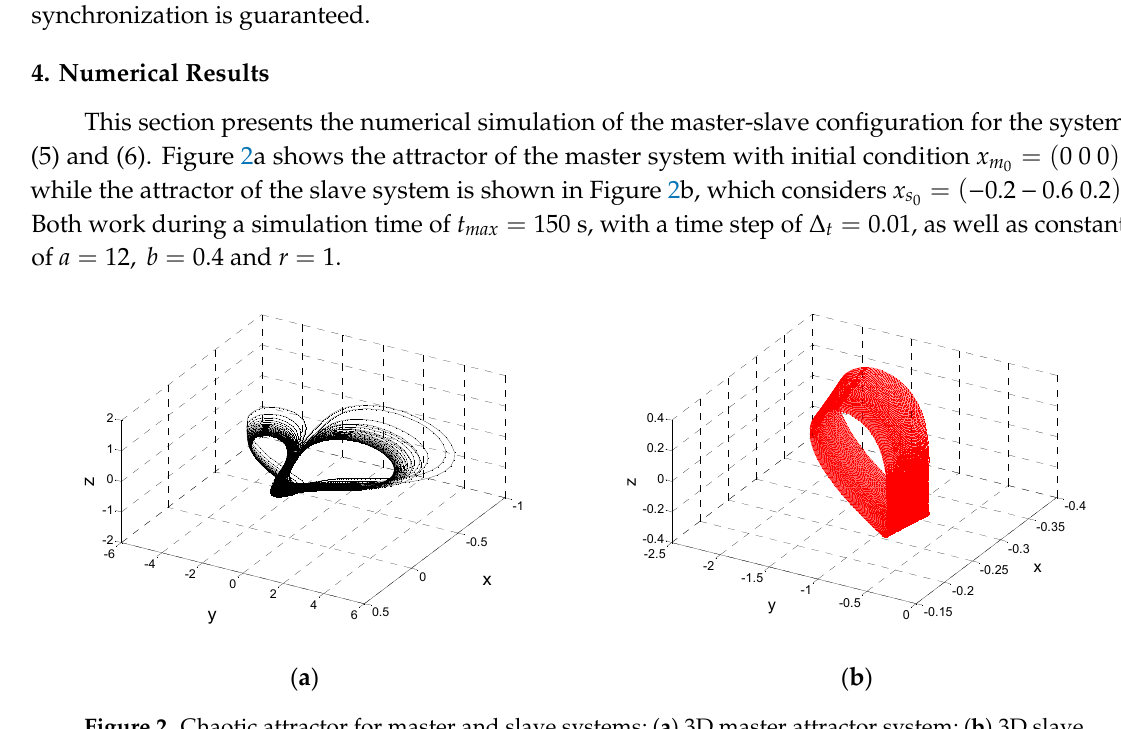
Figure 2. Chaotic attractor for master and slave systems; ( a ) 3D master attractor system; ( b ) 3D slave attractor system.